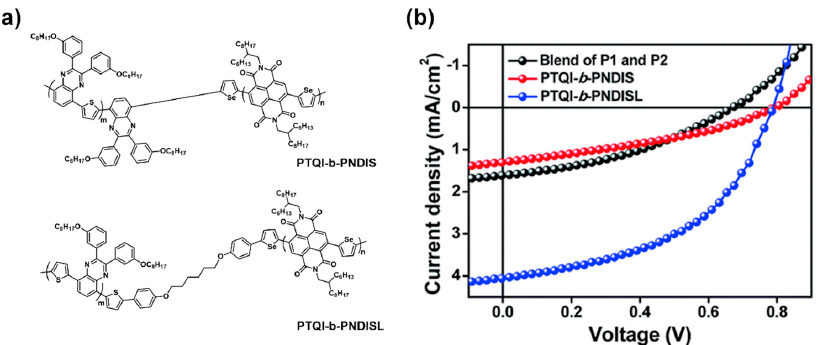
thesized two types of cBCPs (Figure 15a), which were PTQI- b -PNDIS with two